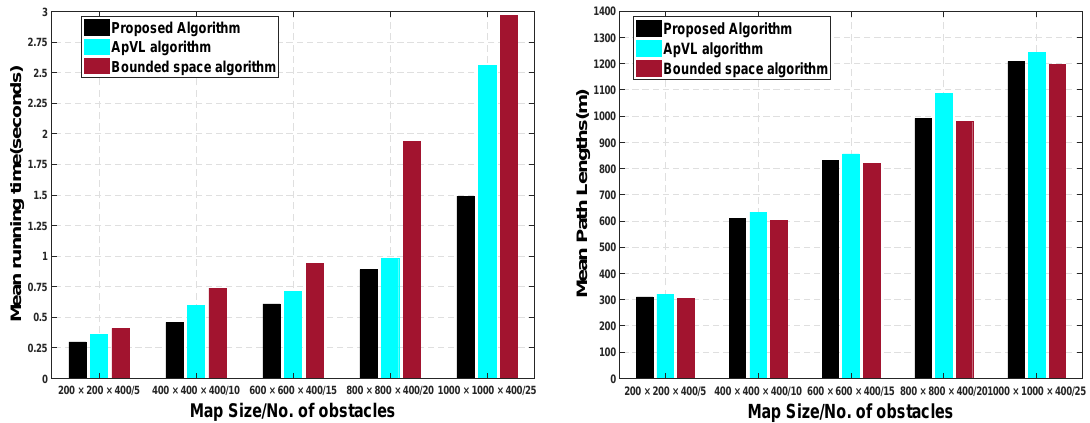
Figure 8. ( Left ): Running time: Proposed algorithm versus ApVL and bounded space algorithm. ( Right ): Path lengths: Proposed algorithm versus ApVL and bounded space